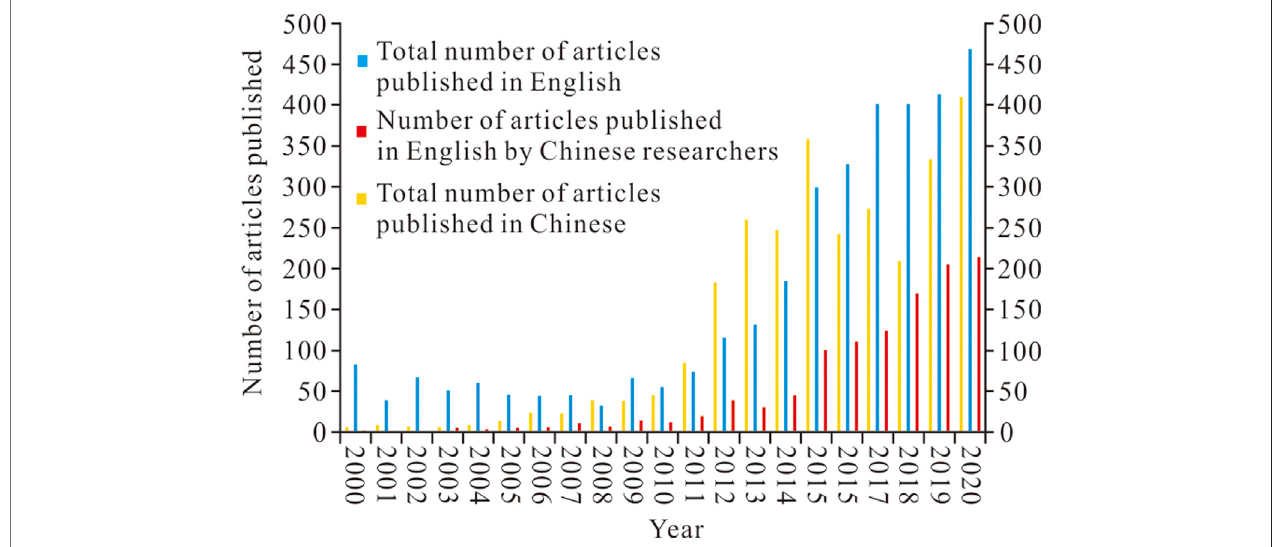
FIGURE1| Statisticalhistogram ofliteratureonshale oilresearch. ThedataofEnglisharticlescome from ScienceDirect, theblue columnrepresentstotaldata,the red column represents researchers from Chinese research institutions, and the data of Chinese articles (orange column) comes from CNKI. The search methods are